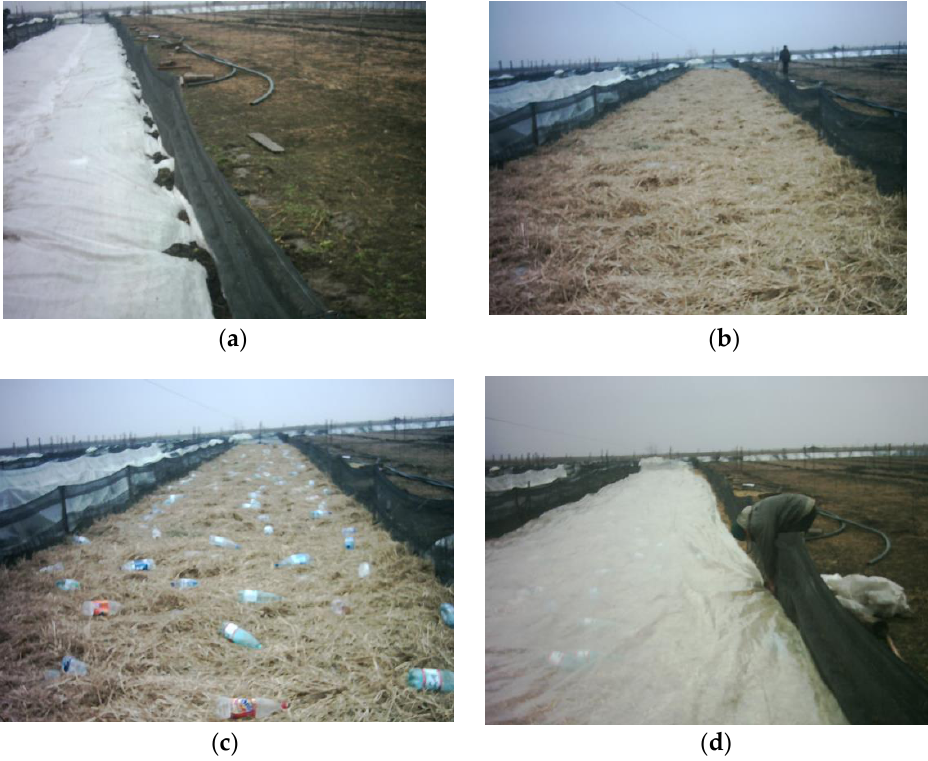
Figure 2. Installation of the “sandwich” system ( a ) Pens covered with a sheet of LFC. ( b ) Layer of straw over LFC. ( c ) PET bottlesabove the layer of straw. ( d ) Structure covered with HDPE sheet.